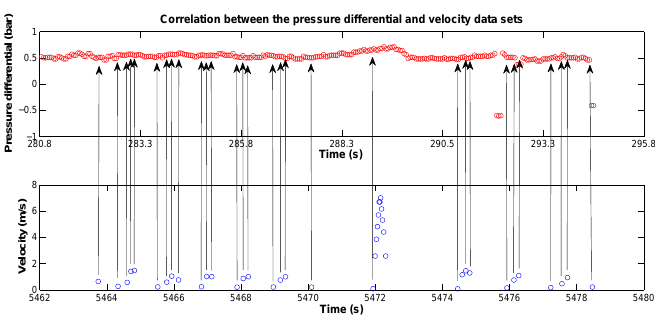
Figure 16. Correlation between the pressure differential and velocity data sets. Source: By Authors.